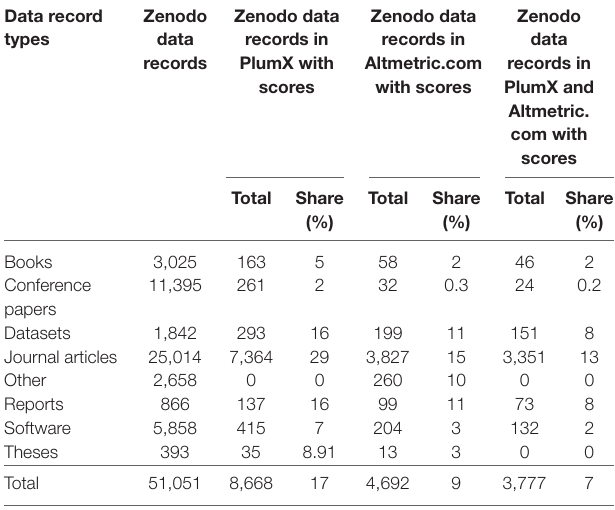
Table 3 | Comparison of data records found in Altmetric.com and PlumX ( n = 51,051; publication years <